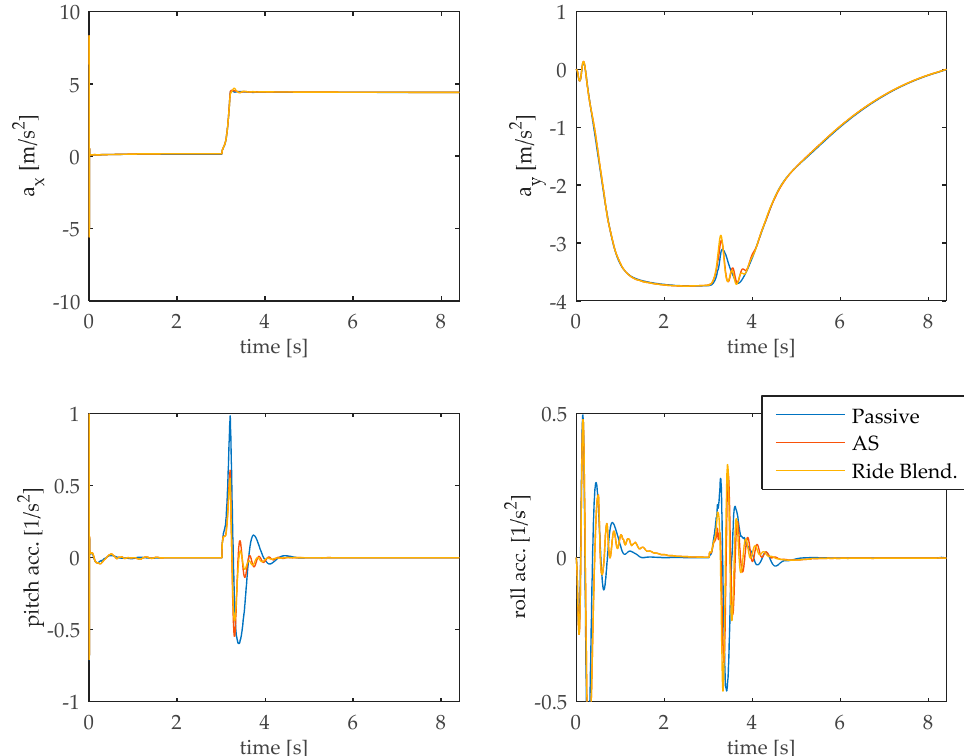
Figure 13. Simulation results for the ISO 7975 brake-in-turn. The upper graphs represent the longitudinal and lateral acceleration, respectively. The lower graphs show the resulting pitch and roll acceleration are reported.